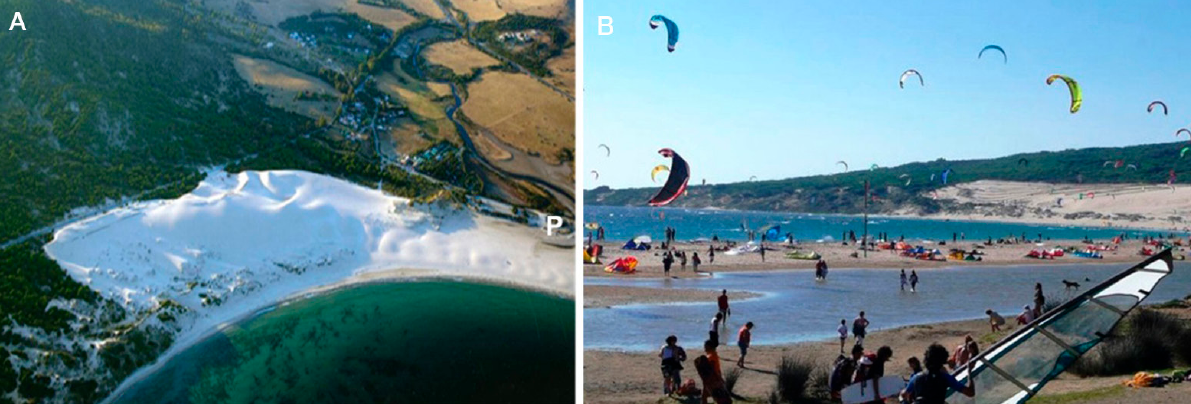
Fig. 4. – A, aerial view of Valdevaqueros beach and dune with the parking lot at its eastern end (point P). B, leisure uses of Valdevaqueros beach with the dune at the